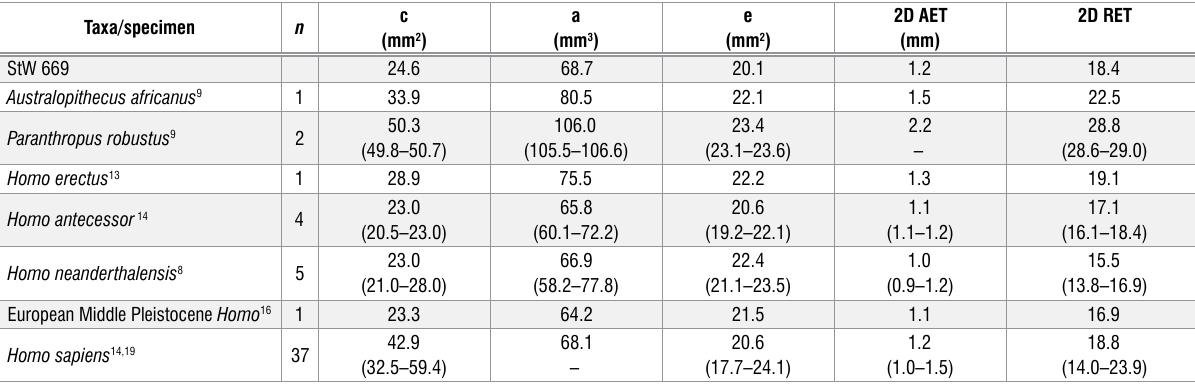
2D crown tissue proportions (including average and relative enamel thickness) of comparative fossil and extant hominins. For samples with more than one assigned specimen, mean as well as range (in parentheses) are given.